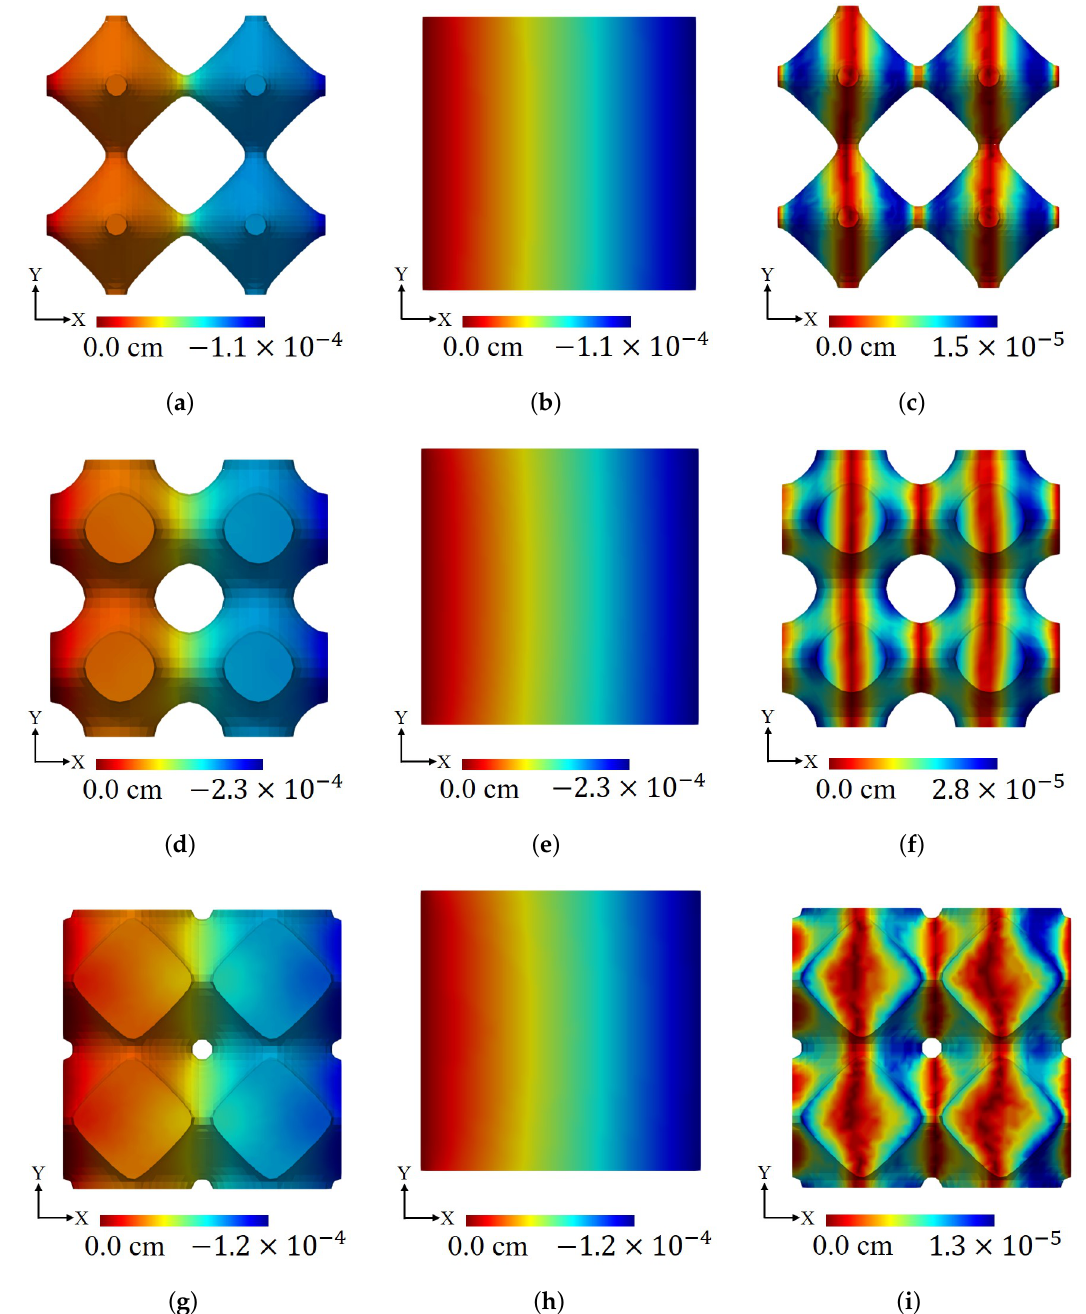
Figure 7. Results of X compression test. Domains of eight cells domains of uniform density. Domain of ρ = 0.25: ( a ) X displacement in lattice domain. Min. displacement: − 1.1 × 10 − 4 cm; ( b ) X displacement in homogeneous domain. Min. displacement − 1.1 × 10 − 4 cm; and ( c ) absolute error. Domain of ρ = 0.50: ( d ) X displacement in lattice domain. Min. displacement: − 2.3 × 10 − 4 cm; ( e ) X displacement in homogeneous domain. Min. displacement − 2.2 × 10 − 4 cm; and ( f ) absolute error. Domain of ρ = 0.75: ( g ) X displacement in lattice domain. Min. displacement: − 1.2 × 10 − 4 cm; ( h ) X displacement in homogeneous domain. Min. displacement − 1.1 × 10 − 4 cm; and ( i ) absolute